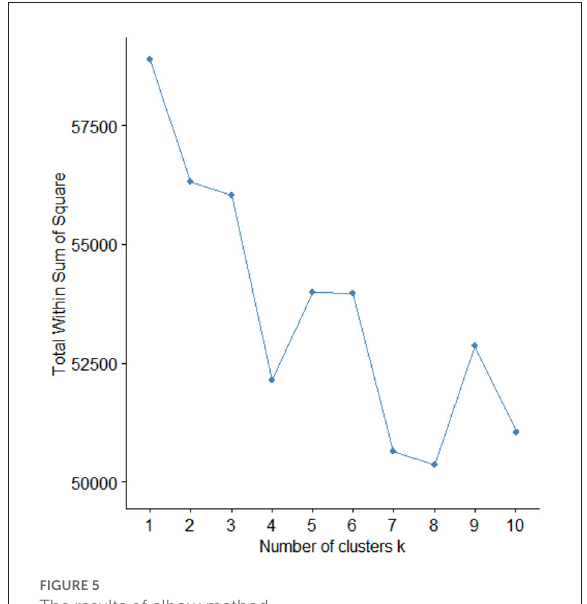
FIGURE5 The results of elbow method.